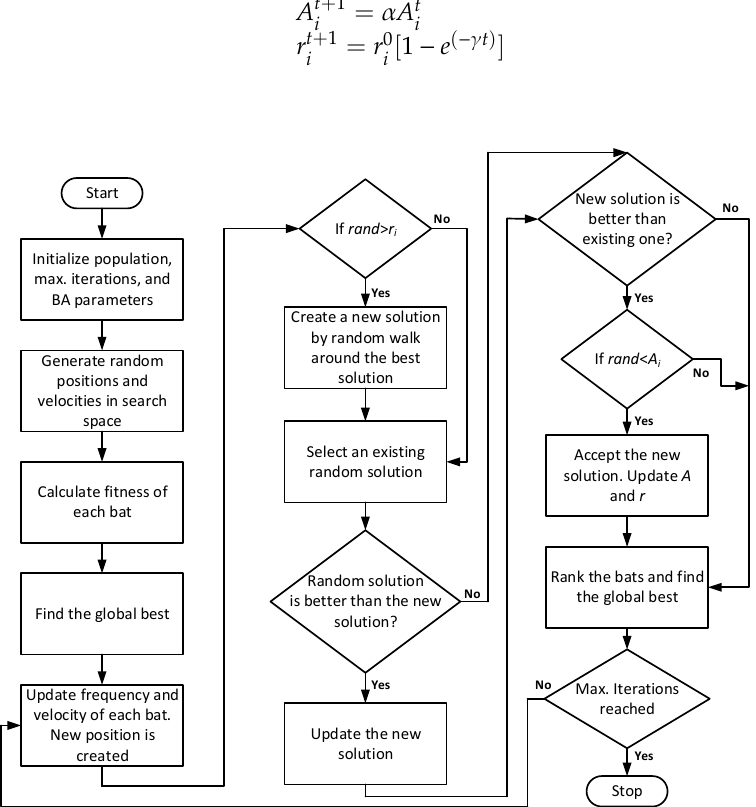
Figure 2. Flow chart of the bat algorithm (BA).